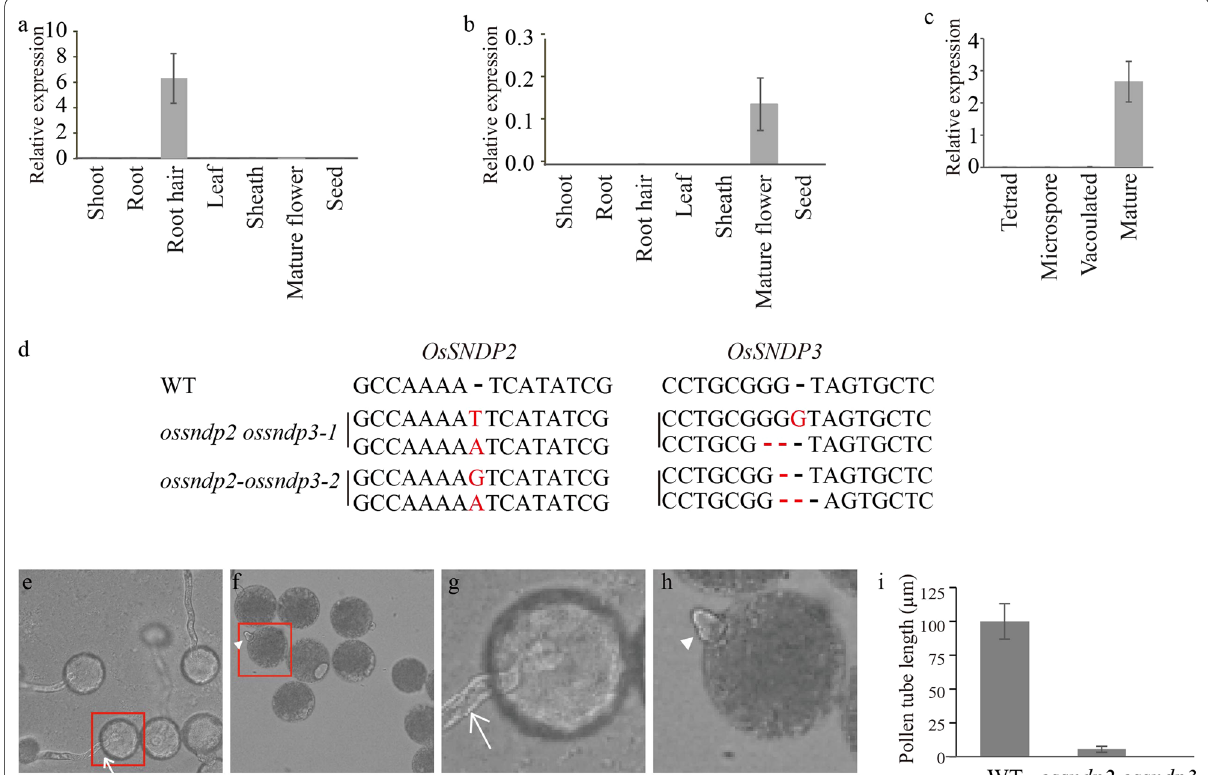
Fig. 5 Double mutant phenotype of ossndp2 ossndp3 . The expression pattern of OsSNDP1 ( a ) and OsSNDP2 ( b and c ). d Sequencing analysis of the target region of CRISPR/Cas9 on OsSNDP2 and OsSNDP3 from double mutants. Red characters indicate inserted sequences by the gene‑editing system and red dashes indicate deleted sequences. In vitro pollen germination from wide type ( e and g ) and ossndp2 ossndp3 ( f and h ). Pictures were taken 30 min after germination on the solid germination media. Arrow indicated long pollen tube from wild type and triangle marked protrusion of pollen tube. Magnified images of the red box were shown in g and h . Representative images were taken from ossndp2 ossndp3-1. i pollen tube length from wild type and ossndp2 ossndp3 . Values are means ( SE) of pollen tube lengths (n > 20 pollen ±